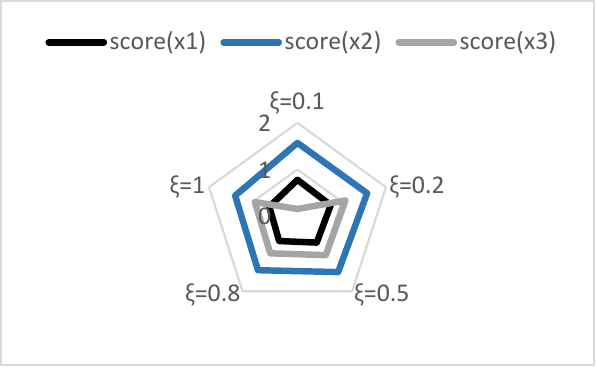
Figure 4. The scores of three companies as 𝜉 changes.